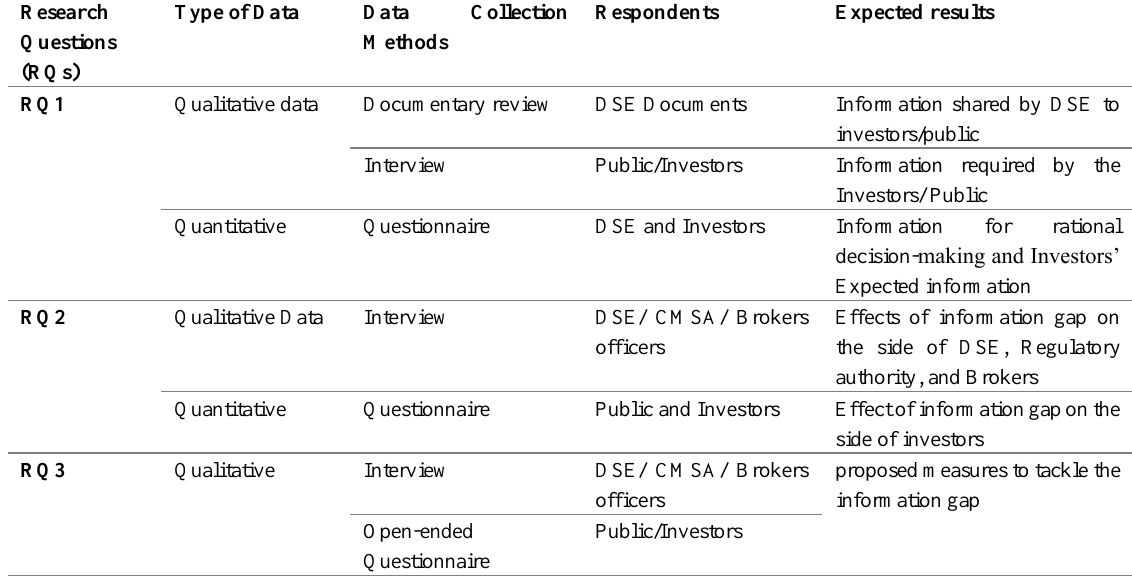
Table 1: Relationship of research questions, type of data, collection methods, and expected results